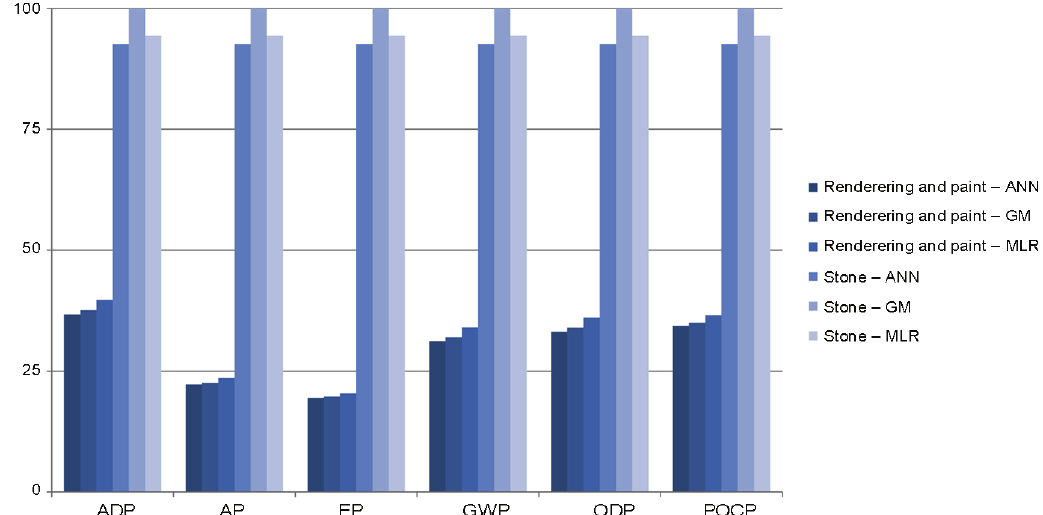
Fig. 1. lCA results (in relative percentage in each environmental category) of each alternative for cumulative stages “A1–A3 and B4” using the reference value of stochastic